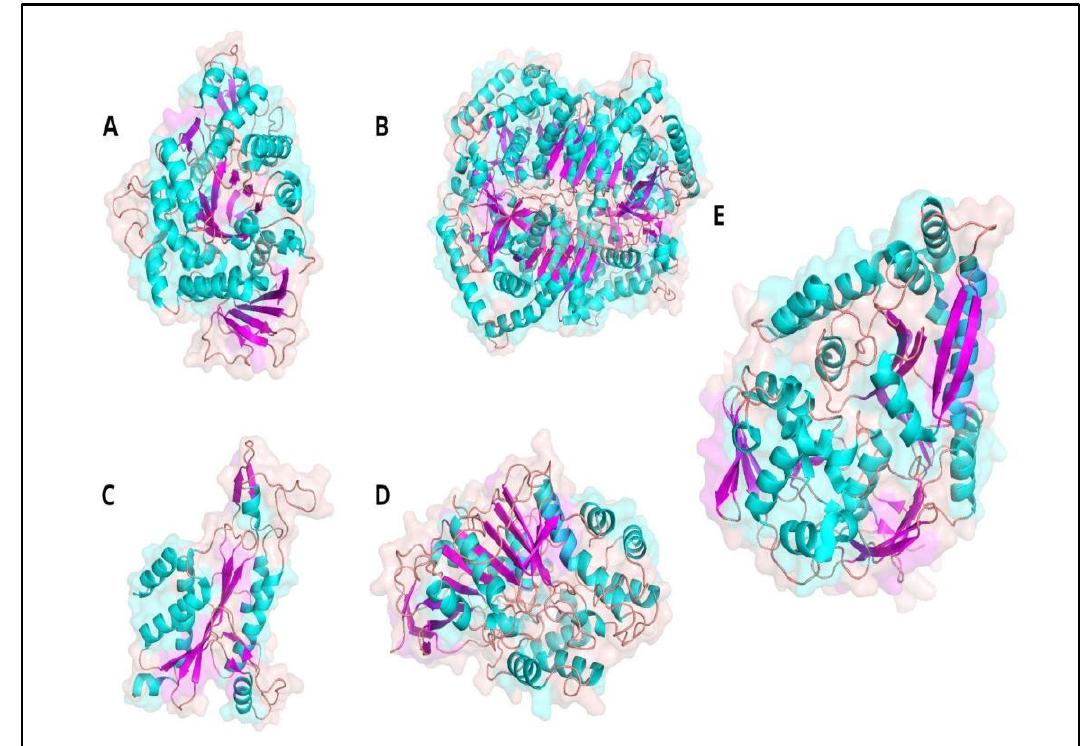
Figure 1. View of the OppA and its possible ligand crystal structures in the ribbon model used at this study. ( A ) Crystal structure of the alpha-glucosidase monomer from Saccharomyces cerevisiae S288C (Mal12). ( B ) Crystal structure of a tetramer of rabbit muscle Oryctolagus cuniculus , lactate dehydrogenase (LDH). ( C ) Crystal structure of the E. coli endonuclease dimer in complex with DNA chain ( Eco RI). ( D ) Crystal structure of Geotrichum candidum lipase (THG). ( E ) Crystal structure of OppA from Yersinia pestis .